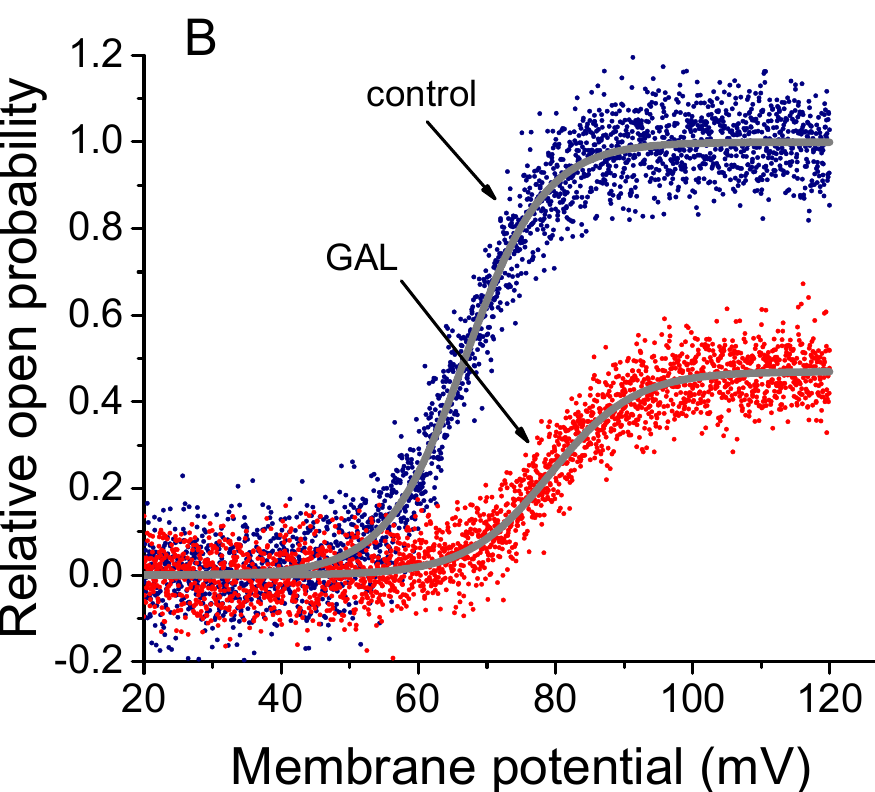
Figure 5. The voltage-dependent effect of GAL-021 on the activity of BK Ca channels identified in GH 3 cells. The experiments were conducted with symmetrical K + concentration, and we filled the electrode with K + -containing solution. Under inside-out current recordings, the potential was maintained at +60 mV and bath medium contained 0.1 μ M Ca 2+ . ( A ) Failure of GAL-021 to modify the single-channel conductance of BK Ca channels. The voltage ramp pulses from 0 to +120 mV with a duration of 1 sec were used to measure single-channel conductance taken with or without GAL-021 addition. The straight broken line with a reversal potential of 0 mV represents the I-V relations of the channels in the absence (upper) or presence (lower) of GAL-021 (3 μ M). (B) Effect of GAL-021 on the sigmoid activation kinetics of BK Ca channels. The currents illustrated were activated by applying the upsloping ramp pulses from +20 to +120 mV with a duration of 1 sec. The continuous lines showed Boltzmann fits of the data yielding 66.8 mV for the control (i.e., GAL-021 was not present) and 79.3 mV obtained as the detached patch was exposed to 3 μ M GAL-021.